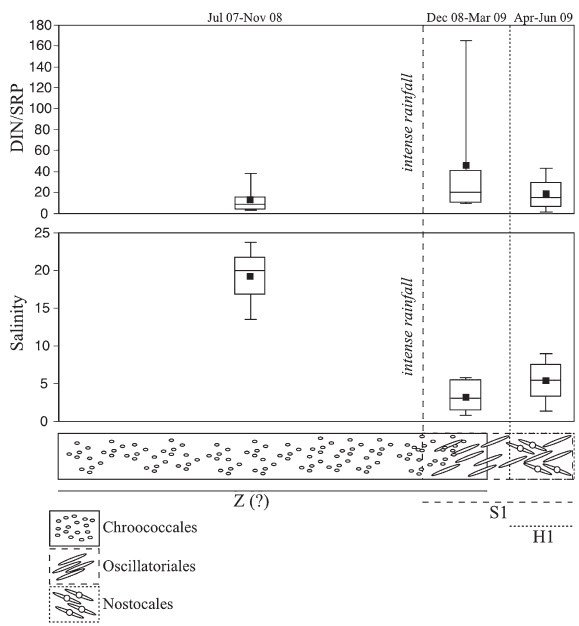
Fig . 10. – Conceptual model of the cyanobacteria succession that af- fected Cabras Lagoon during the investigation period. The whiskers extend from the 10th percentile to the 90th